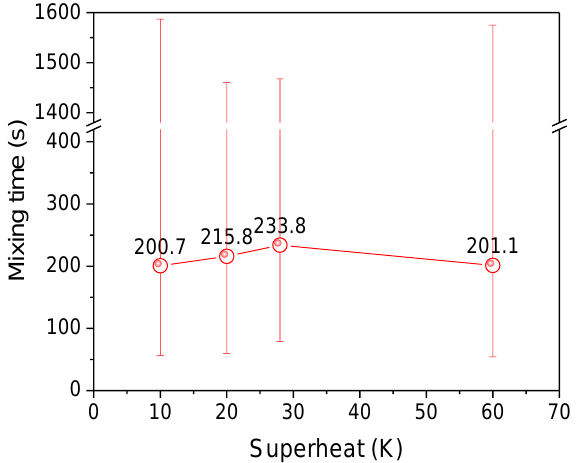
Figure 14. E ff ect of superheat on the maximum alloy mixing Figure 14. Effect of superheat on the maximum alloy mixing time.